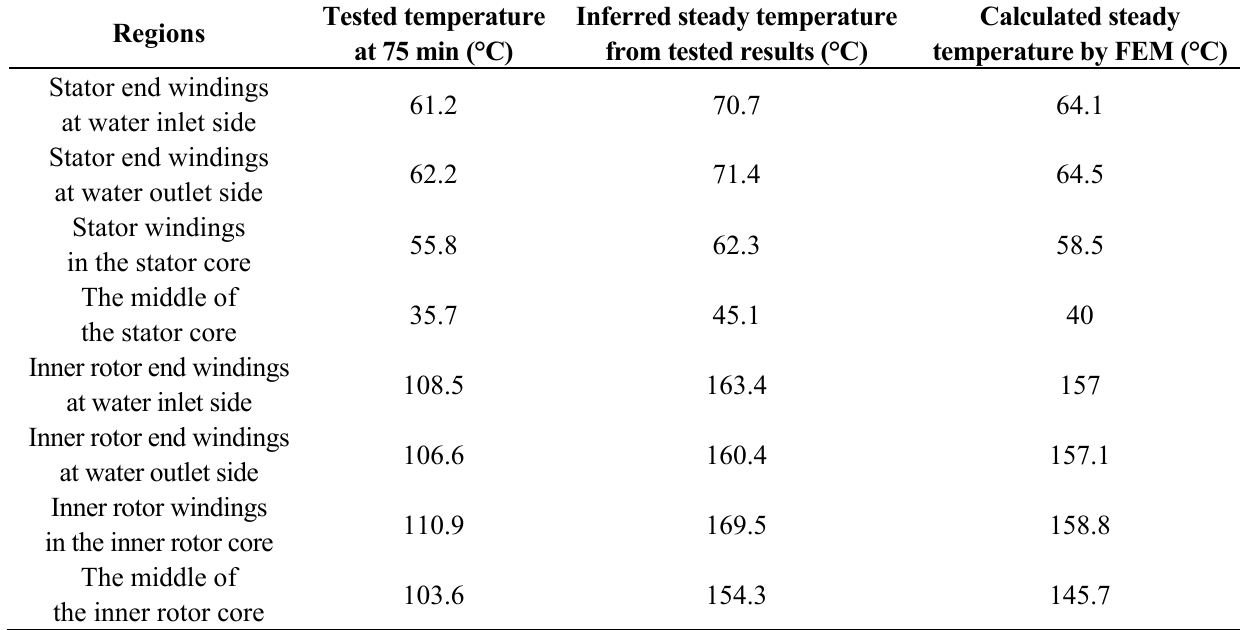
Table 15. Calculated and tested highest temperatures in the prototype when the SM and DRM run at rated torque and low speed, and only water cooling is used in the casing. Tested temperature Inferred steady temperature Calculated steady Regions at 75 min (°C) from tested results (°C) temperature by FEM